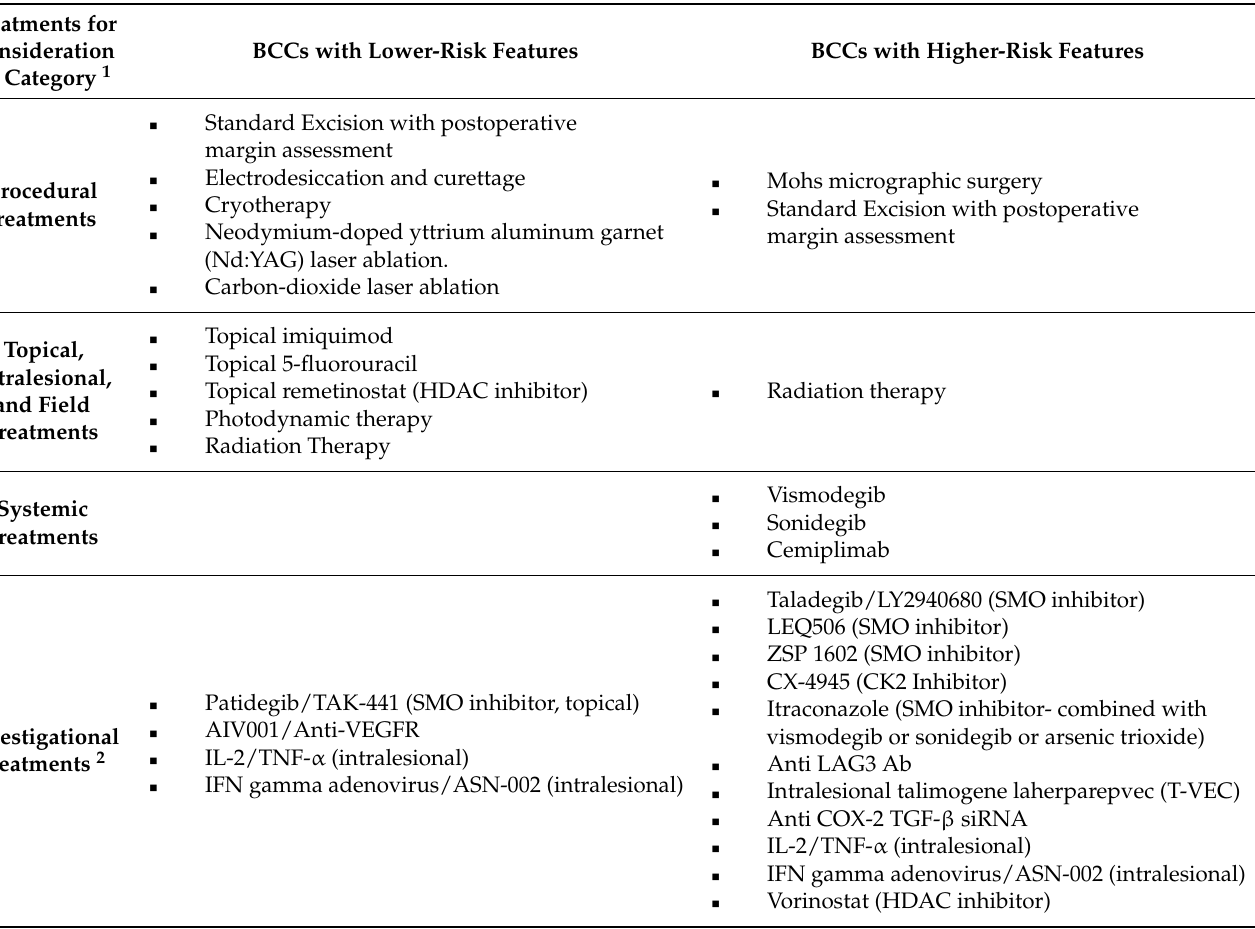
Table 1. Treatments for consideration by category for BCCs with lower or higher-risk features.